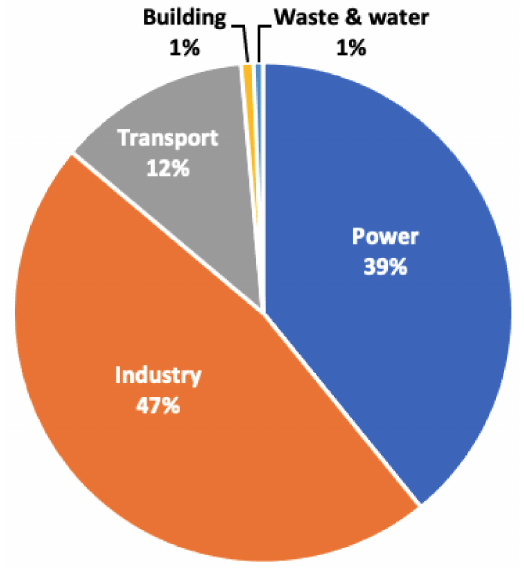
Figure 2. Singapore’s CO 2 emission in